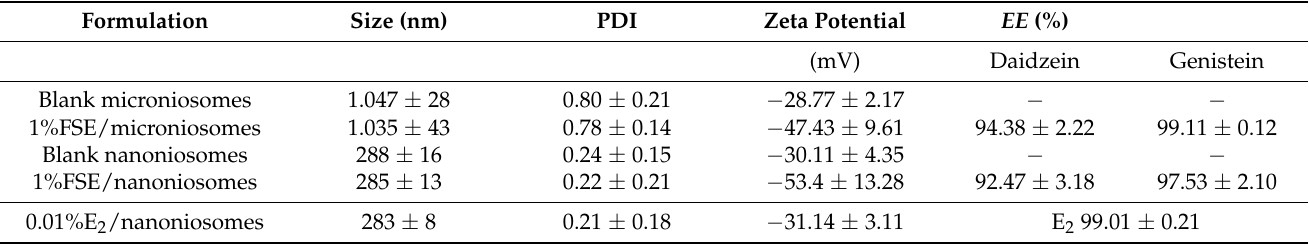
Table 1. Physicochemical characteristics of niosome formulations.